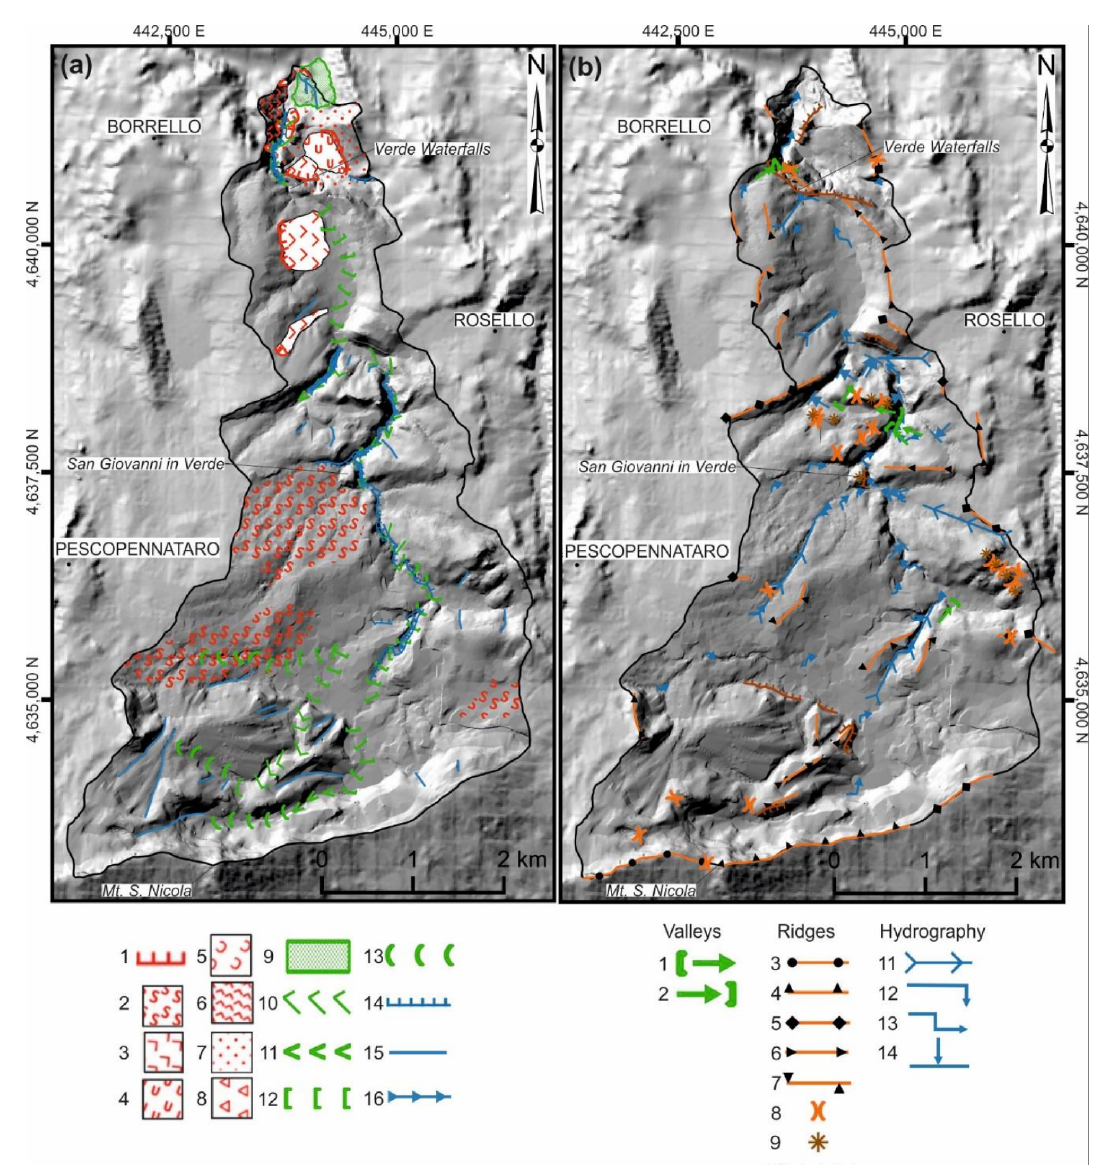
Figure 10. ( a ) Map of the fluvial and slope gravity landforms. In black: the watershed boundary. Legend: (1) degradational and/or landslide scarp; (2) soil creep; (3) rotational slide; (4) translational slide; (5) earthflow; (6) complex landslide; (7) deep-seated gravitational slope deformation (DSGSD); (8) rockfall; (9) badlands area; (10) asymmetric valley; (11) V-shaped valley; (12) flat bottom valley; (13) concave valley; (14) fluvial erosion scarp; (15) gully; (16) entrenched fluvial segment. ( b ) Morphotectonic scheme. In black: the watershed boundary. Legend: (1) beheaded valley; (2) hanging valley; (3) straight symmetric ridge; (4) straight asymmetric ridge; (5) ridge; (6) altimetric discontinuities of ridge; (7) planimetric discontinuities of ridge; (8) saddle; (9) isolated relief; (10) structural scarp; (11) rectilinear fluvial segment; (12) river bend; (13) double river bend; (14) 90 ◦ confluence. Other ridges and the altimetric and planimetric discontinuities of the ridges show a NNW–SSE trend. Several saddles are distributed mostly on a NNE–SSW direction. Asymmetric valleys feature a SSE–NNW trend. Rectilinear fluvial segments are found with a NE–SW trend. River bends show